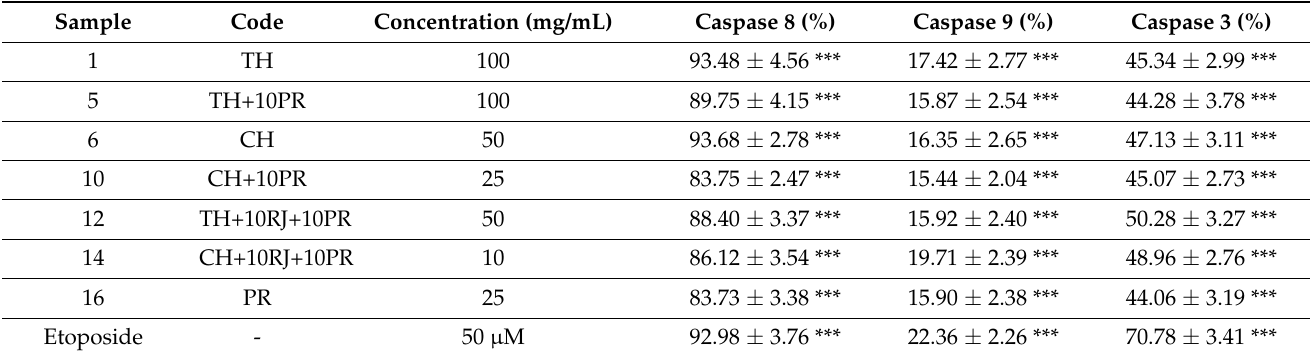
Table 4. Activation of caspases 8, 9, and 3 by the selected samples (1, 5, 6, 10, 12, 14, and 16) and etoposide at 48